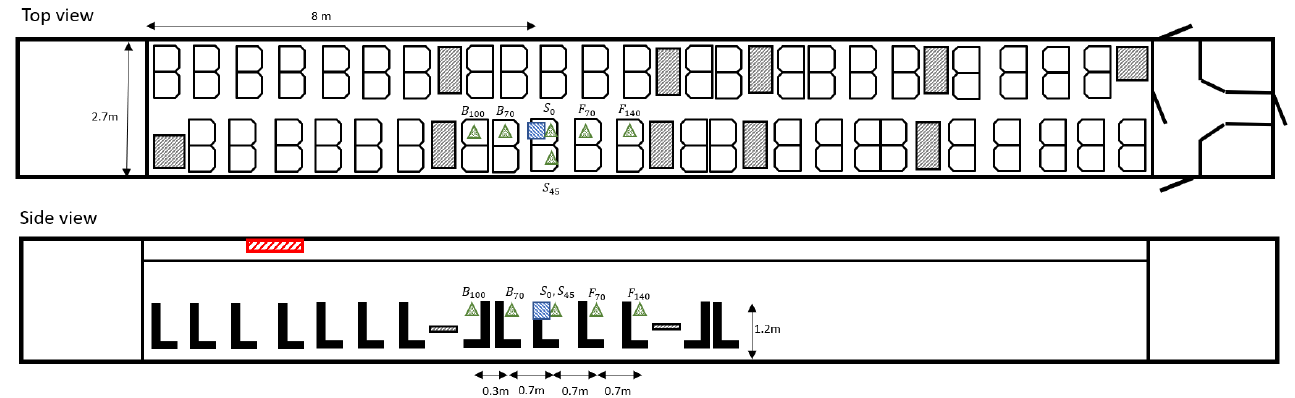
Figure 5. Aerosol dispersion experiment setup. The location of the nebuliser is shown by the blue square and the PM sensors are shown by green